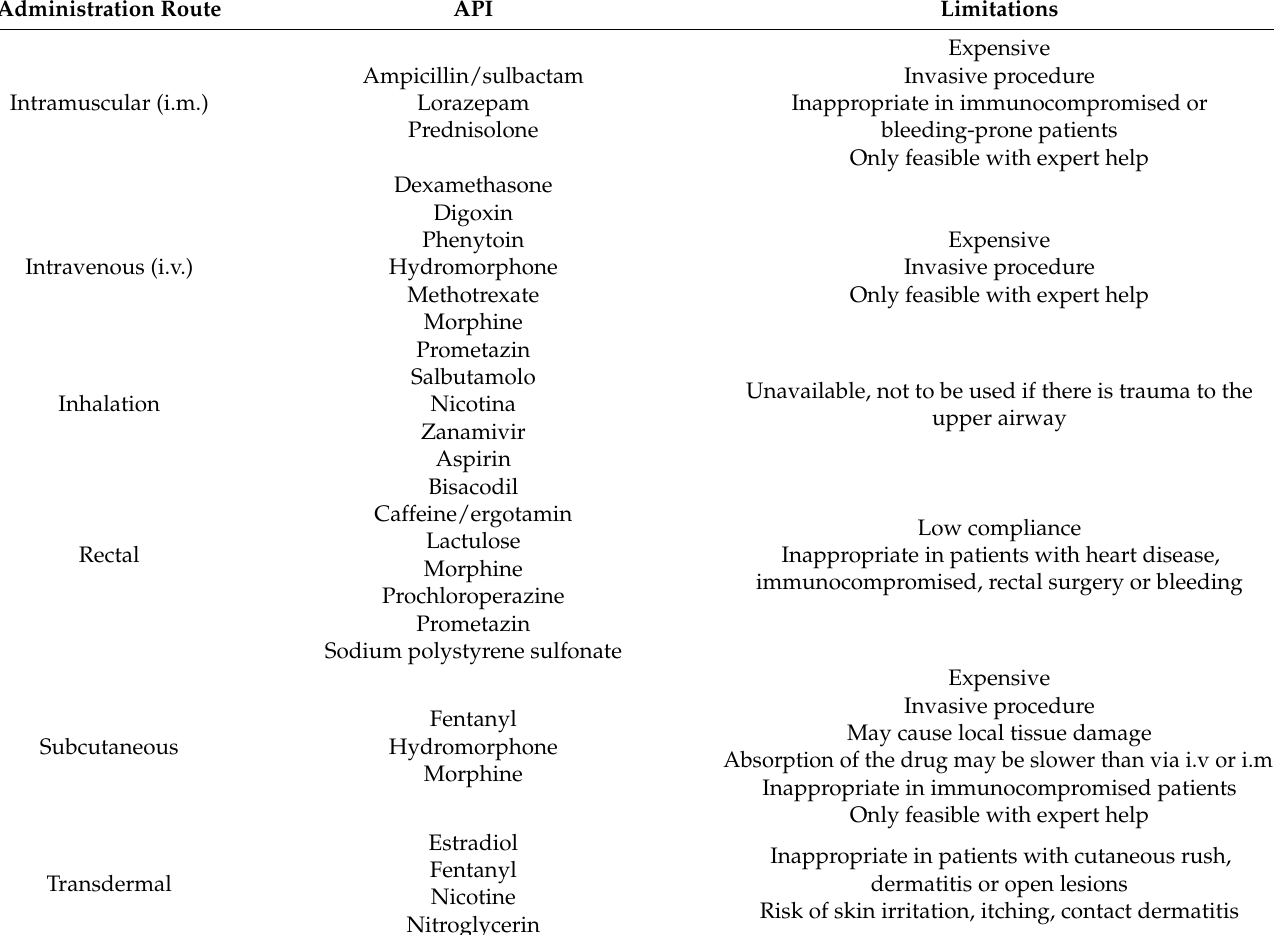
Table 2. APIs endowed with formulations alternative to oral